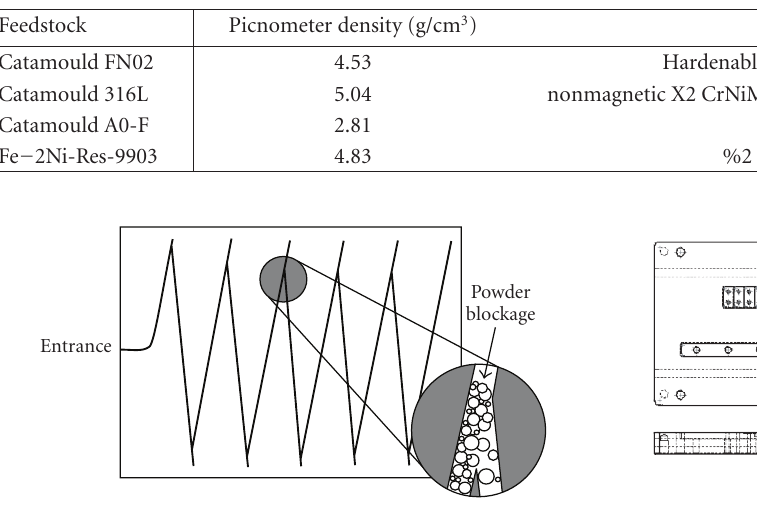
Table 1: Feedstocks and their chemical contents.